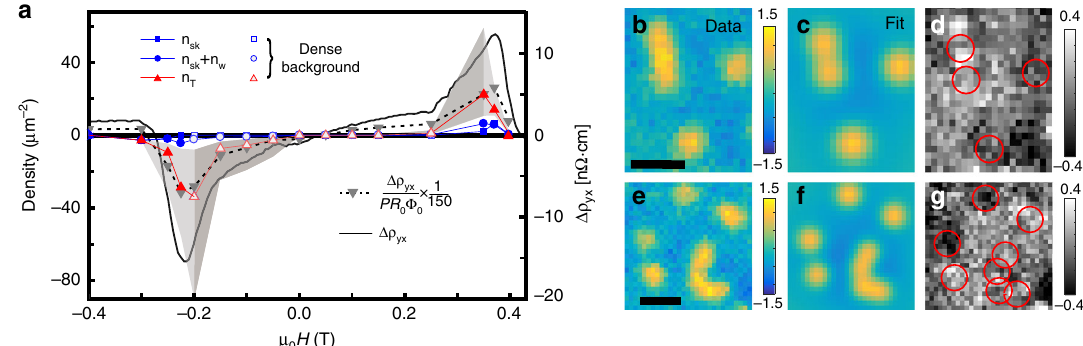
Fig. 3 Comparison between Δ ρ yx and the signed density of topological charge at 5 K. a Right axis: Δ ρ yx (solid line). Left axis: n sk (squares), n sk + n w (circles), n T (triangles), and Δ ρ yx /( PR 0 Φ 0 ) (cf. Eq. (2), inverted triangles with dotted line) using P = 0.56 43 and R 0 from Fig. 2b. For n T , each worm is assigned several skyrmions | Q W | by fi t, and each isolated skyrmion is counted once. Empty symbols indicate points with a lower con fi dence, that result from counting worms in a dense background (Supplementary Note 7). Shaded area shows con fi dence bounds for n T resulting from fi t details (Supplementary Note 7). b , e Zooms on areas in Fig. 1i with skyrmions and isolated worms. c , f Results of MEFS fi ts wherein all skyrmions, including those assigned to worms, are treated as identical. The fi t peak height ≈ 1.15 Hz, full width at half maximum (FWHM) ≈ 100 nm, and | Q W | = 2 in ( c ) and | Q W | = 4 in f . d , g Difference plots between b and c , and between e and f , showing the quality of the fi t. Circles give the locations of the skyrmions in the fi t. [The scale bars in b and e are 200